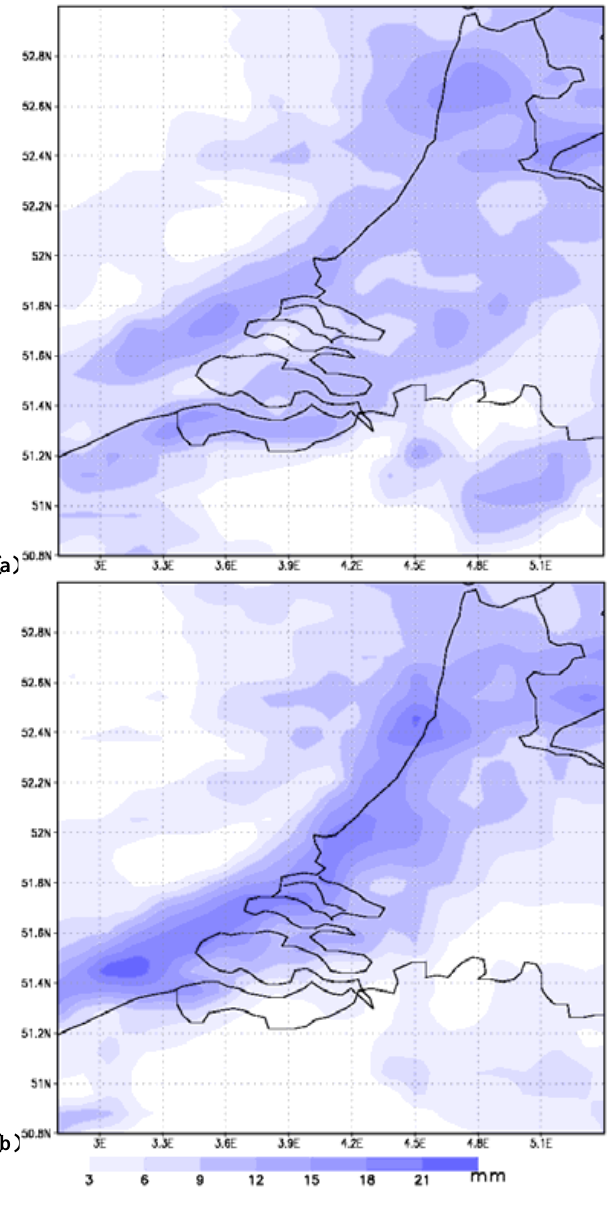
Fig. 6. Accumulated precipitation amounts (mm), calculated by the Kain-Fritsch-Blackadar combination (a) and the Kain-Fritsch- Burk-Thompson combination (b) , over the time period between 12 August 2004 12:00 UTC and 13 August 2004 12:00